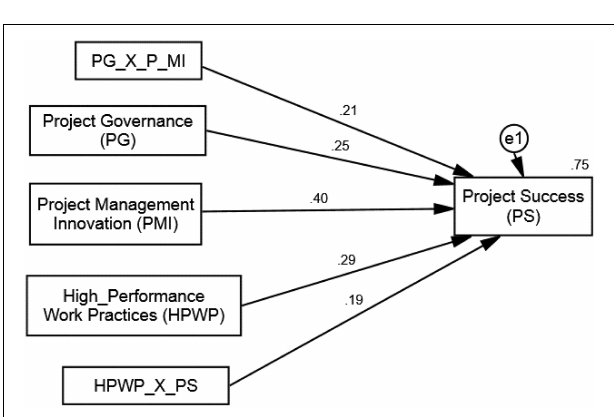
FIGURE 4 | Structural model 2 (with two